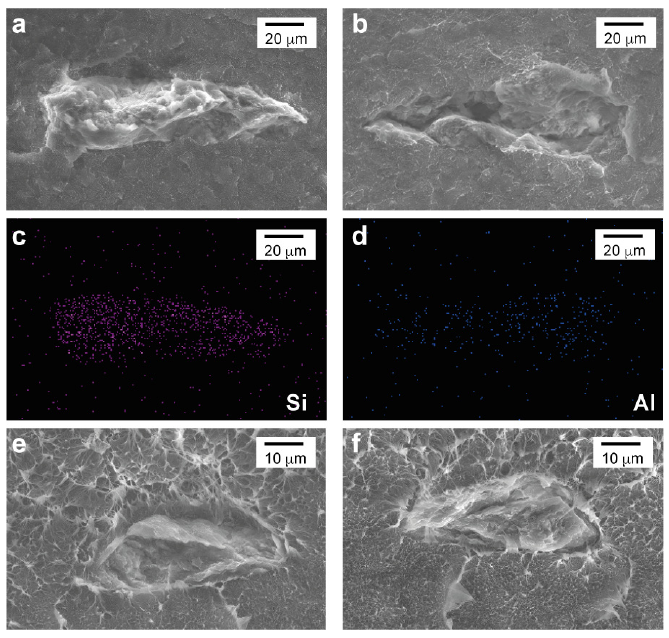
Figure 6. Agglomerate debonding and fracture on the HDPE-3 nanocomposite (containing a 3 wt% of nanoclay).